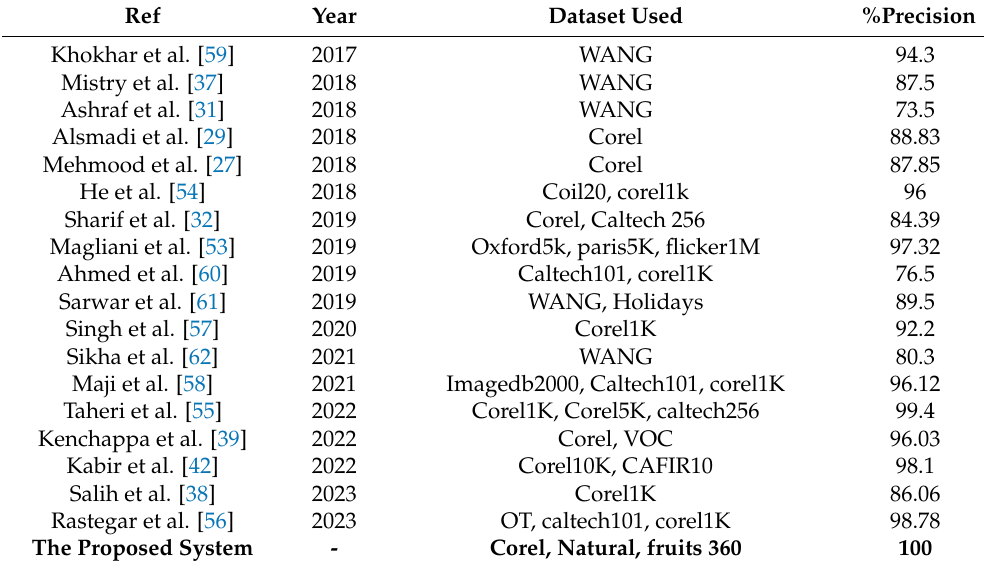
Table 5. Comparison of precision with existing